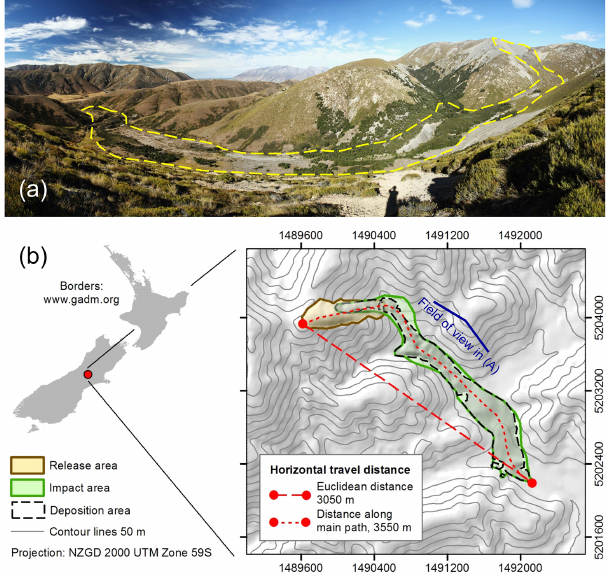
Figure 4. Acheron rock avalanche. (a) Panoramic view; photo: M. Mergili, 28 February 2015. (b) Location and geometry.